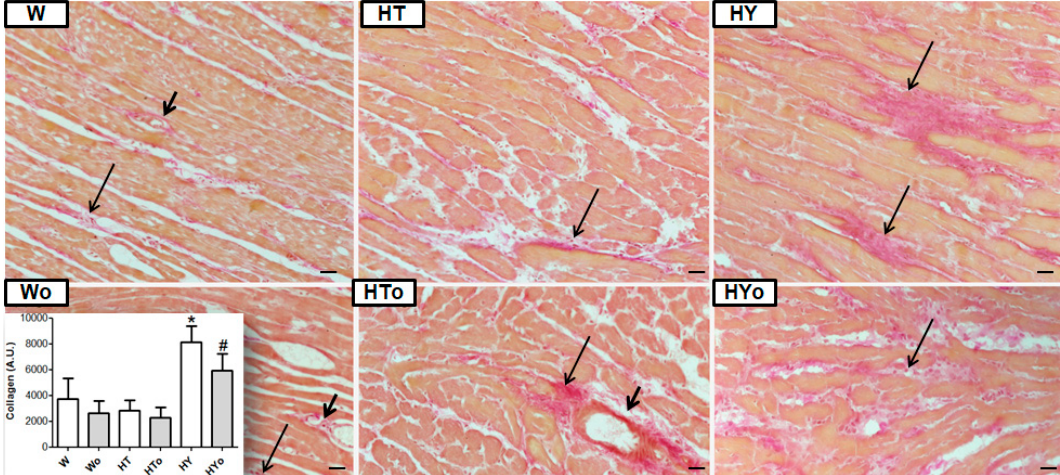
Figure 9. Representative images of van Gieson staining and quantitative analysis of collagen deposition in the male normotensive rats with altered thyroid status, fed with or without Omacor. Interstitial fibrosis—long arrows; Perivascular fibrosis—short arrows. W—Wistar Kyoto euthyroid control rats; o—fed with Omacor; HT—hyperthyroid rats; HY—hypothyroid rats. Objective 40×. Scale bar 10 µm. Data are presented as means ± SD; * p < 0.05 vs. W; # p < 0.05 untreated vs. treated with Omacor.